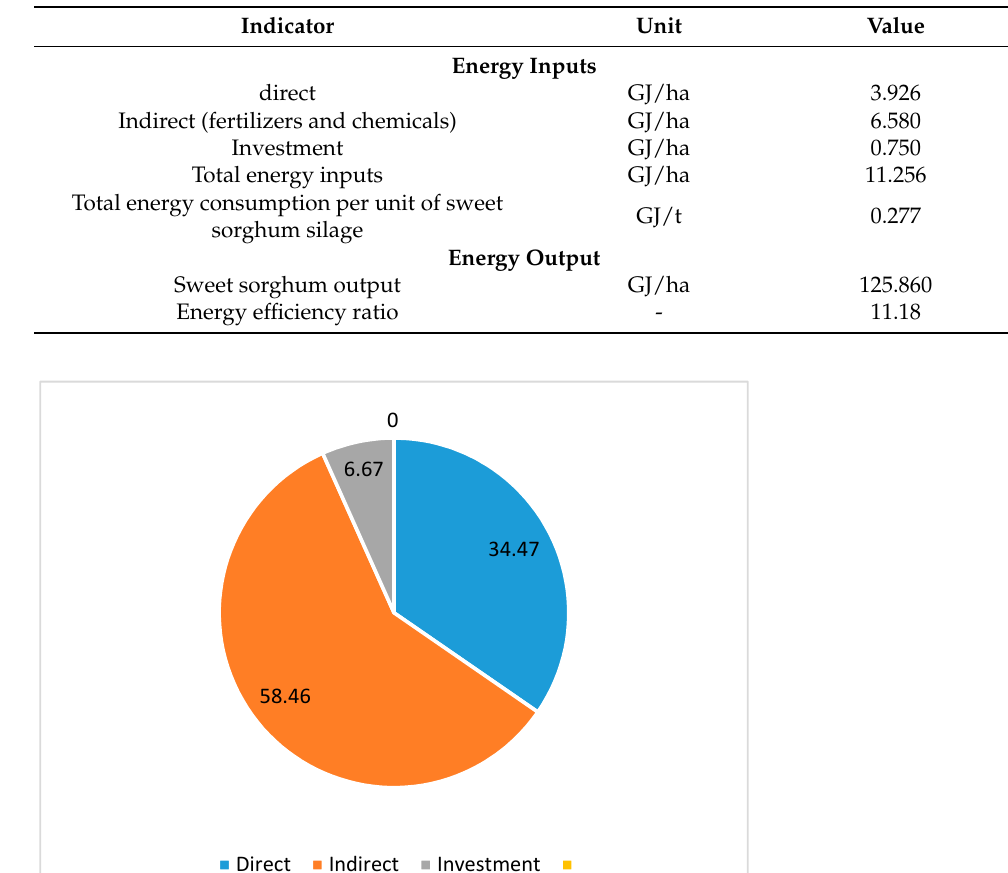
Table 9. The main energy indicators of the technology.